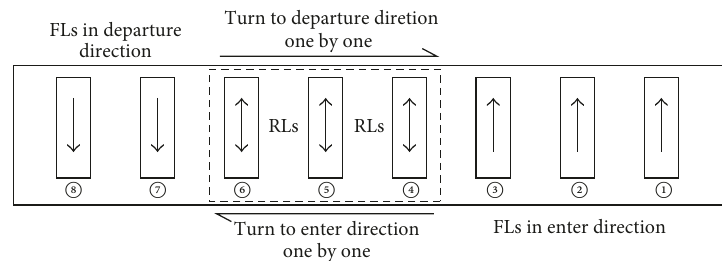
Figure 2: Changing order of